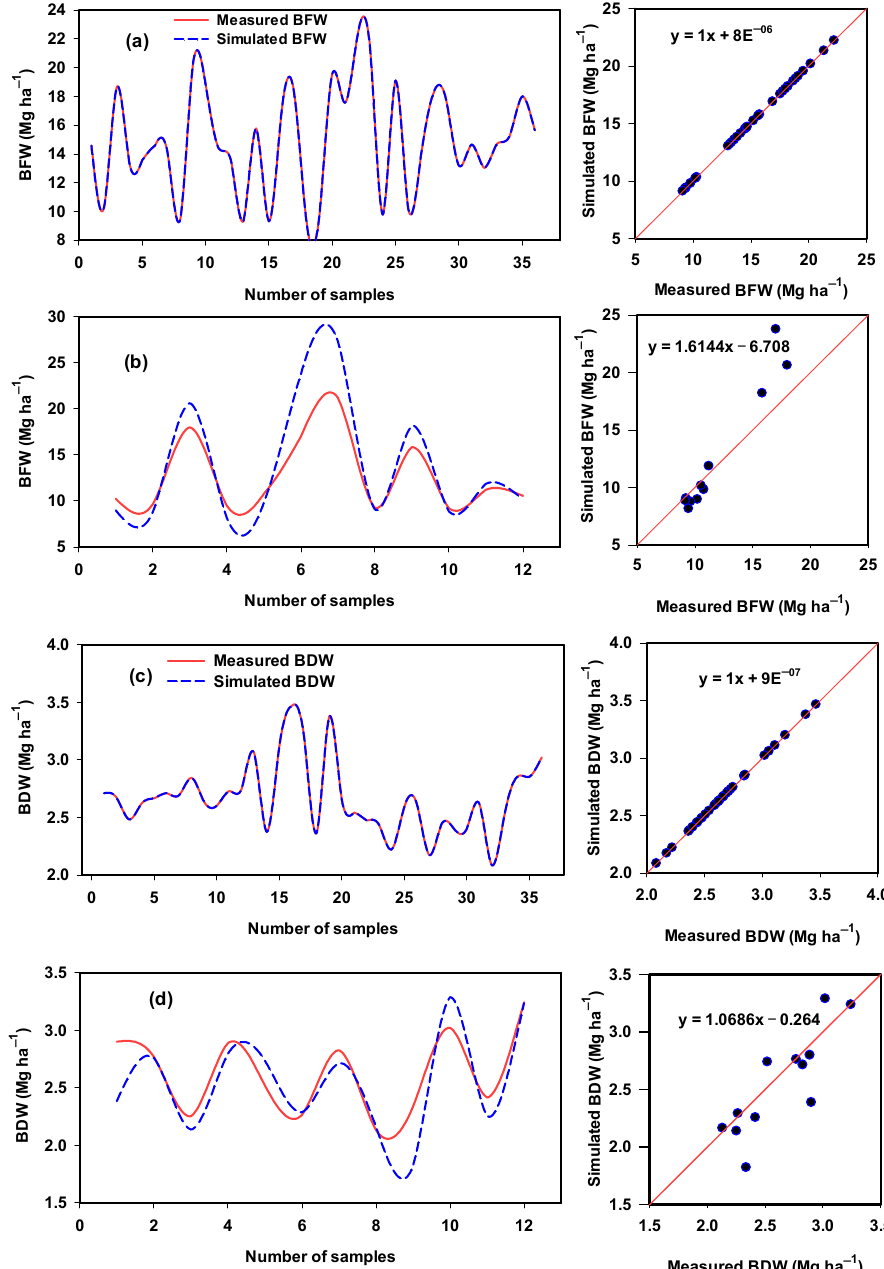
Figure 7. Comparison between training series ( a , c ) and testing series ( b , d ) for biomass fresh weight (BFW) and biomass dry weight (BDW) of two potato varieties using the developed ANFIS model.